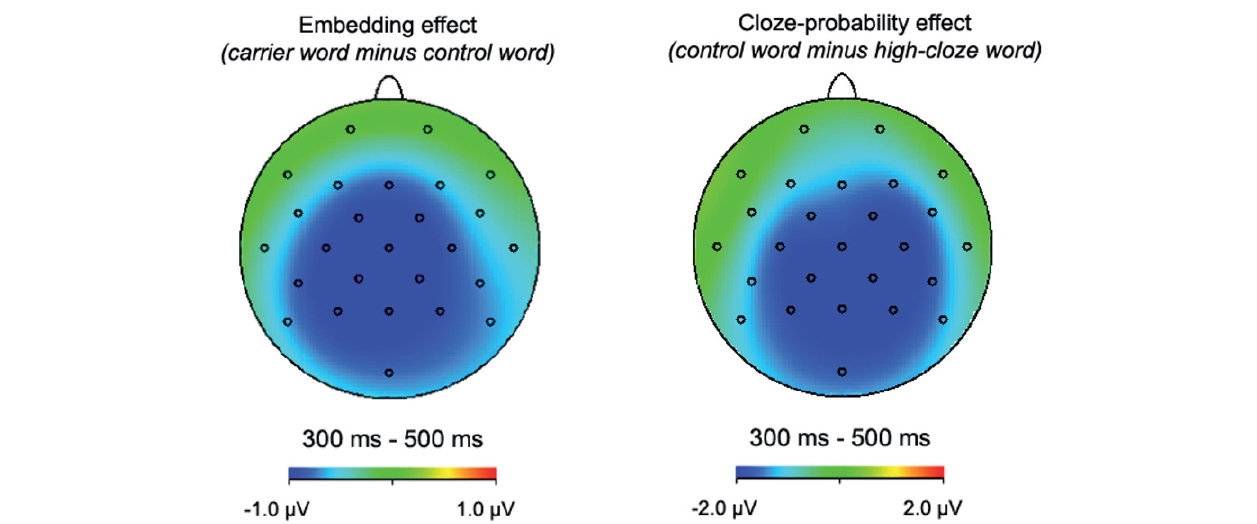
standard N400 effect caused by a difference in cloze-probability for the complete word (control word minus high-cloze word, time-locked onto the onset of the words). Note that the range of the scales differ for the two